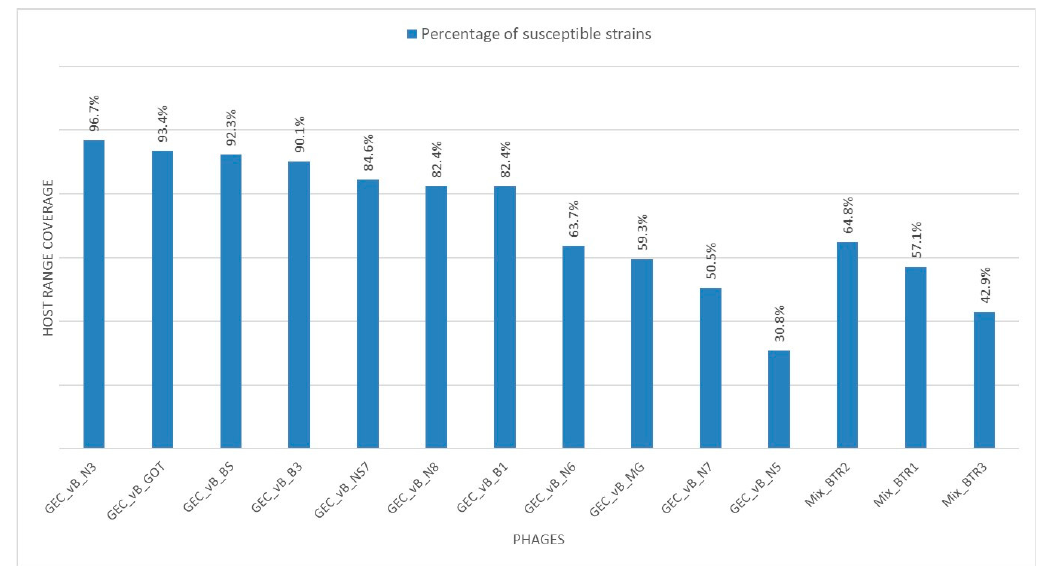
Figure 4. Host range coverages of 11 phage clones and 3 phage cocktails to 91 Salmonella isolates from the Caucasus.